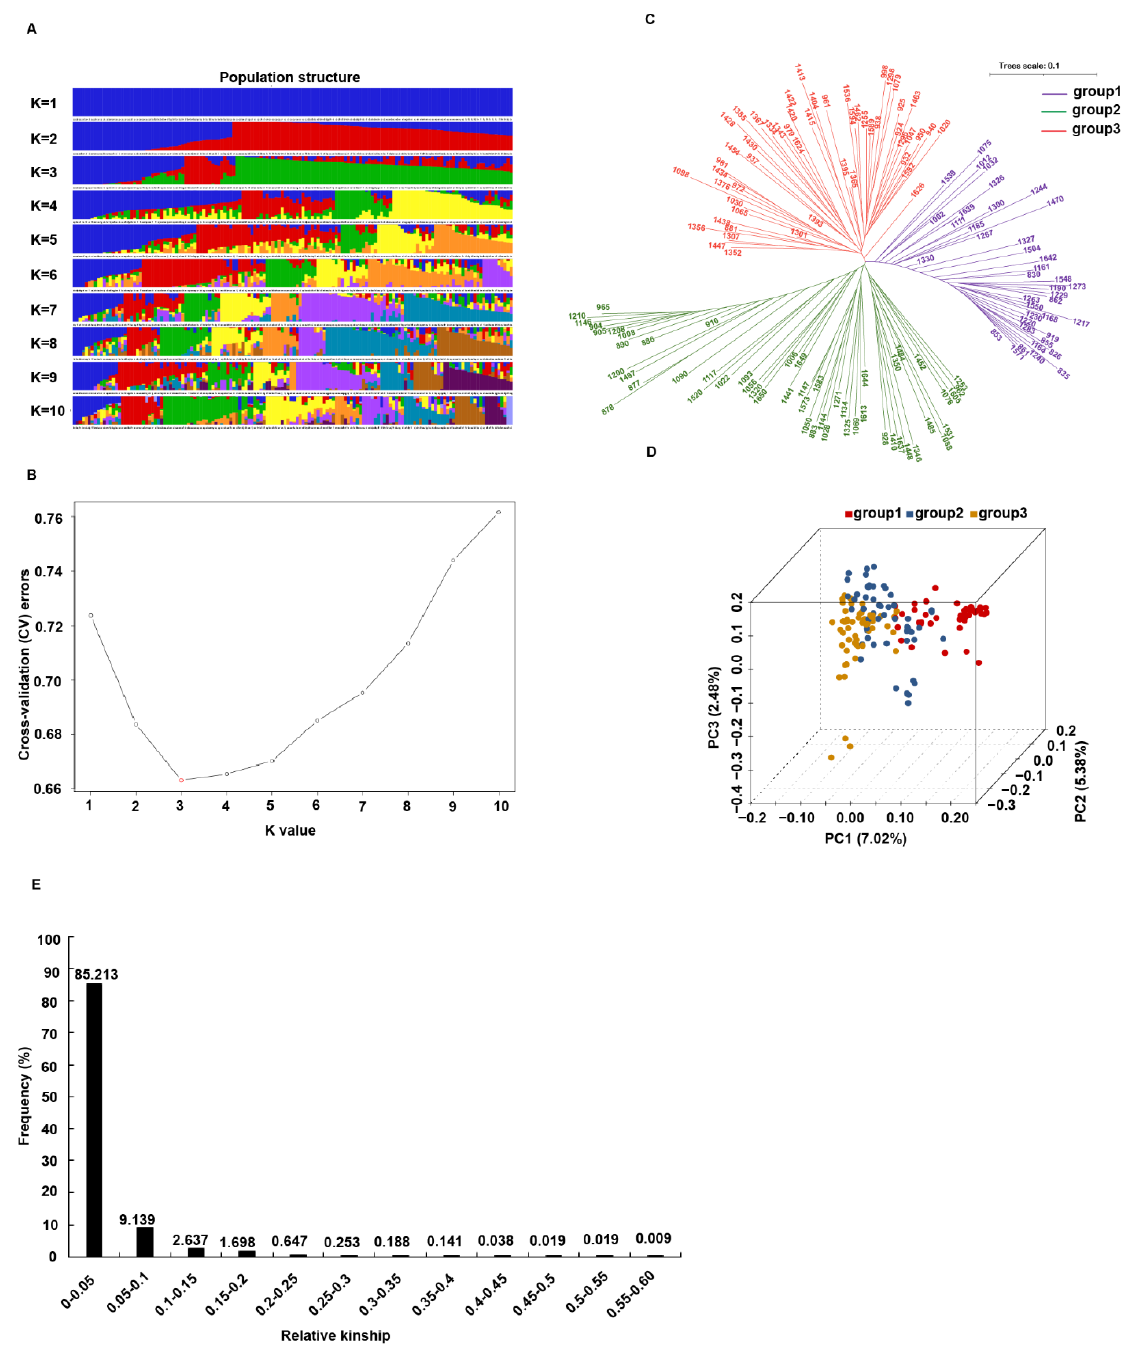
Figure 3. The population structure and relative kinship analysis for the 146 rapeseed accessions. ( A ) The population structure of rapeseed accessions estimated by ADMIXTURE. The colors represent separate groups. ( B ) Cross validation error rate for each K-value. ( C ) Phylogenetic tree of 146 rapeseed accessions. Different colors represent different subgroups: group1-group3. ( D ) Three-dimensional PCA scatter plots. The accessions were divided into three subgroups: group1–group3. The three axes refer to PC1, PC2, and PC3, respectively. Each dot represents a sample. ( E ) Distribution of pairwise relative kinship of rapeseed accessions.